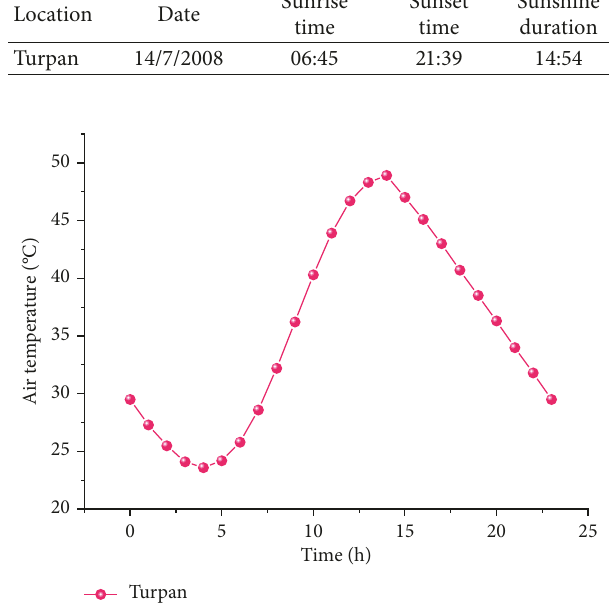
Figure 9: Air temperature on the representative date in Turpan.